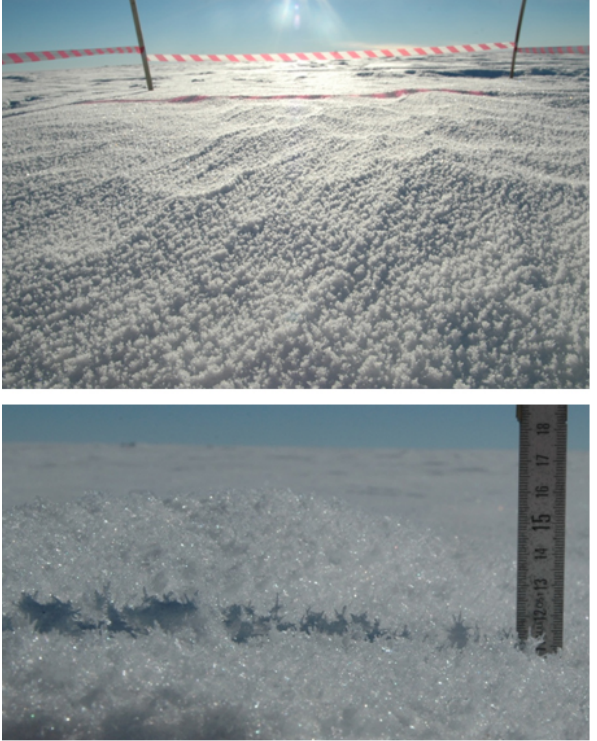
Figure 1. Sublimation crystals and surface hoar crystals on the sur- face of the snowpack at Dome C on 18 January